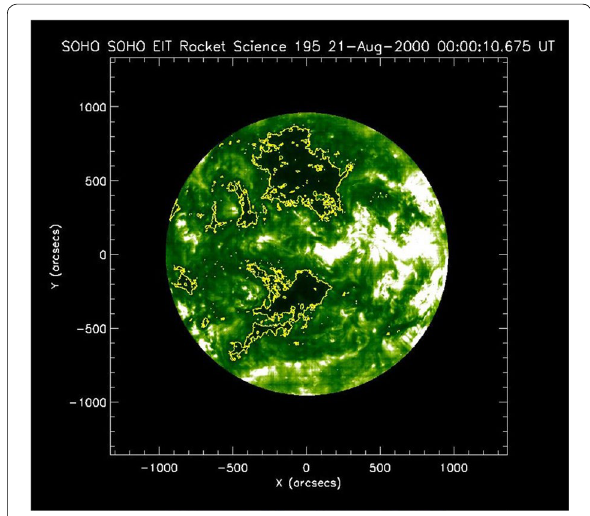
Fig. 4 The two-dimension solar image obtained from SOHO/EIT 195 Ǻ on August 21, 2000. The identified CH in the present study are regions surrounded by a yellow line